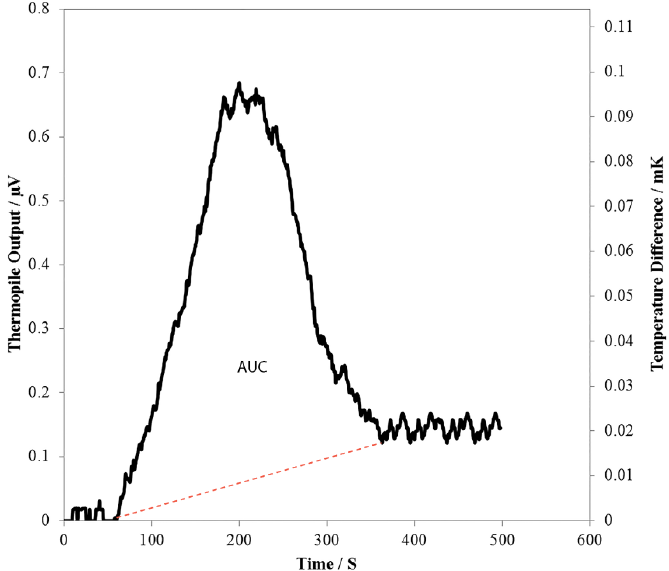
Figure 6. Thermopile output following the injection of 54 mM L-glutamate sample. Sample size used is 5 µL. Secondary ordinate axis represents the temperature rise (calculated from Seebeck coefficient) detected by the thermopile. The dotted line indicated in red shown in the figure is used to determine the area under the curve (AUC).